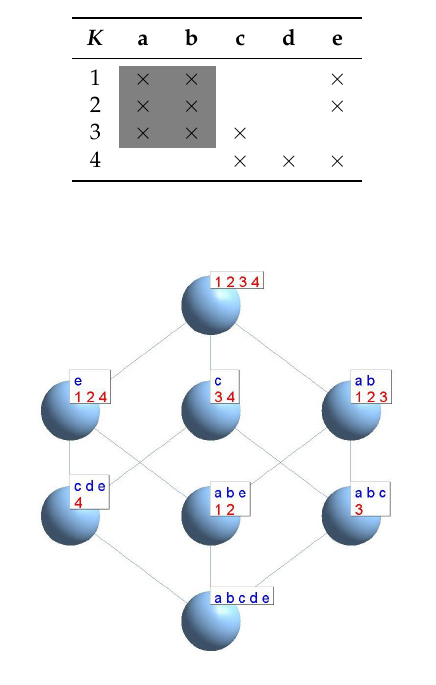
Table 1. Example Formal context K .